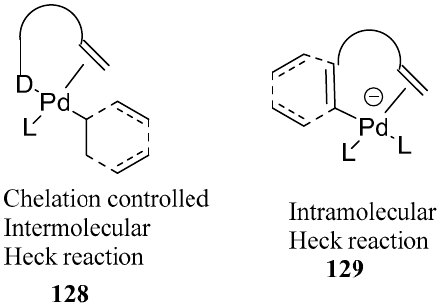
Figure 16. Chelation controlled inter ‐ and intramolecular Heck reaction.